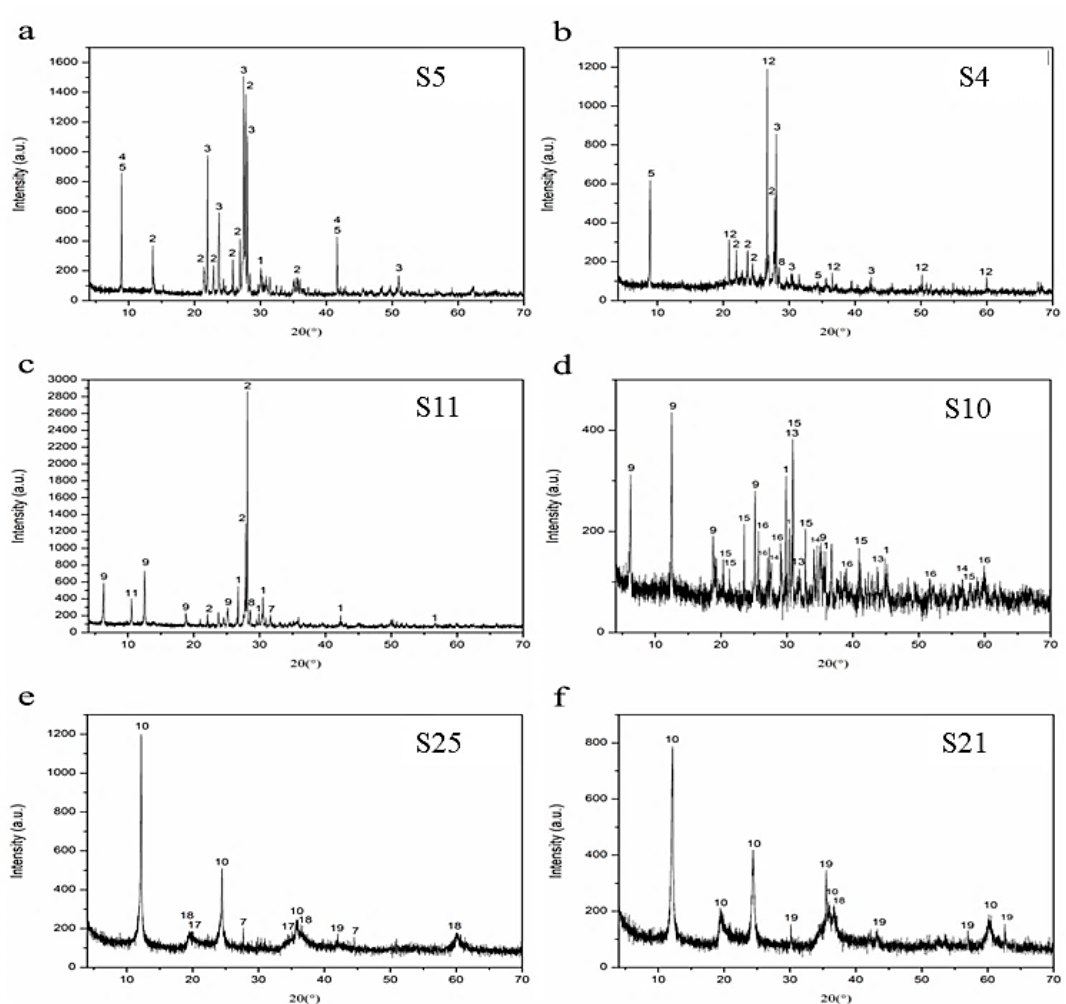
Figure 3. X-ray diffraction (XRD) patterns of the representative investigated samples: ( a ) andesite (Group I), ( b ) dacite (Group I), ( c ) diabase (Group II), ( d ) gabbro (Group II), ( e ) serpentinized harzburgite (Group III), ( f ) serpentinized harzburgite (Group III) (1: clinopyroxene, 2: plagioclase, 3: alkali